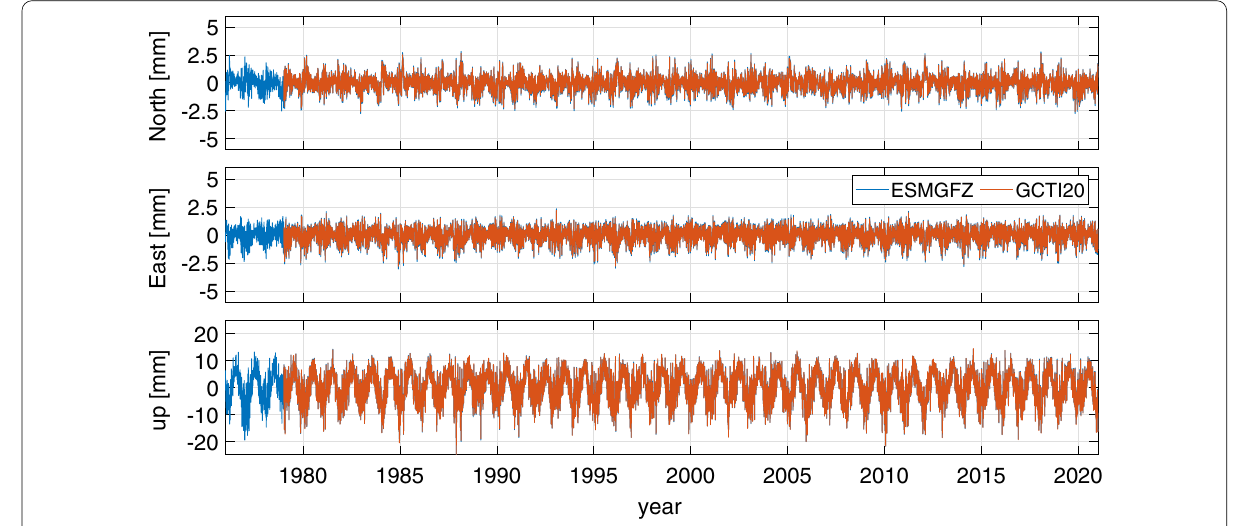
Fig. 2 Same as Fig. 1, but this time the site displacements refer to the